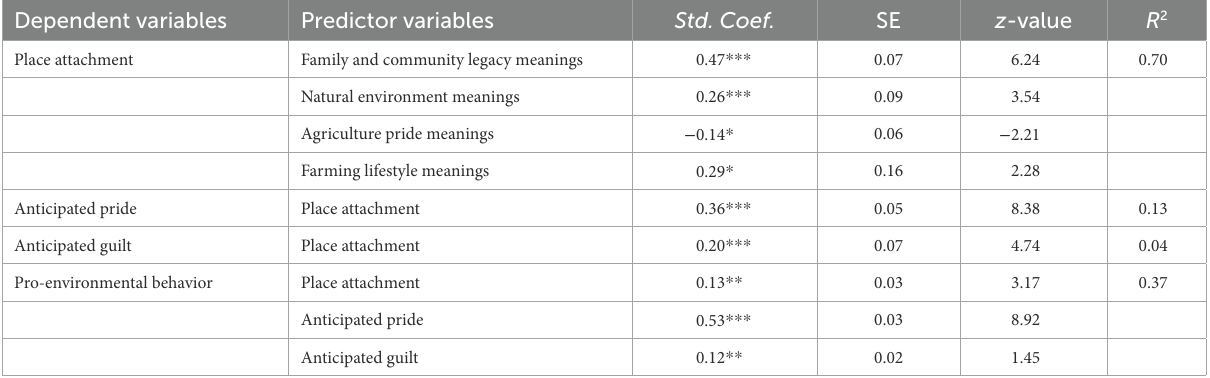
TABLE 4 Results from the latent variable model. Dependent variables Predictor variables Std. Coef. Place attachment